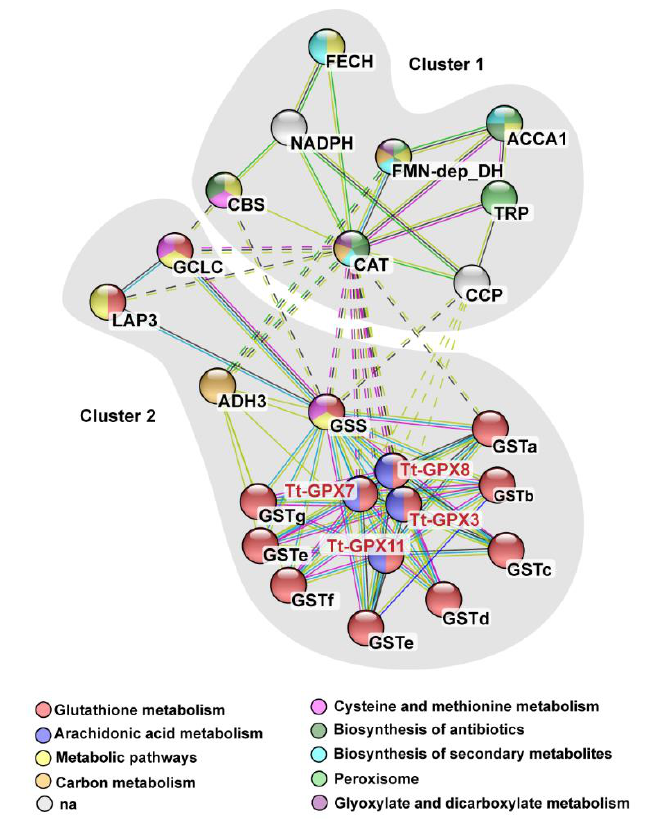
Figure 3. Protein–protein interaction network. The nodes in the network are color-coded in accordance with their Kyoto encyclopedia of genes and genomes (KEGG) pathway categories. The colors assigned for each KEGG pathway are indicated at the bottom of the figure. The color of the lines connecting the nodes (proteins) indicates the typology of protein–protein interaction. The interactions are classified in three groups: know (turquoise = from curated database, pink = experimentally determined interactions), predicted (green = gene neighborhood, blue = gene co-occurrence) and others (yellow = text-mining, black = co-expression). The network has been clustered using the MCL method, and the identified clusters are shown in gray. Interactions that do not belong to the same network are indicated by dashed lines. ACCA1, acetyl-coenzyme A carboxylase carboxyl transferase subunit alpha; ADH3, class III alcohol dehydrogenase; CAT, catalase; CBS, cystathionine- β -synthase; CCP, cytochrome C peroxidase; FECH, ferrochelatase; FMN-dep_DH, FMN-dependent dehydrogenase; GCLC, glutamate-cysteine ligase, catalytic subunit; GSS, glutathione synthase; GST, glutathione S-transferase; LAP3, cytosol aminopeptidase; NADPH, glutamate synthase; TRP, tetratricopeptide repeat protein.